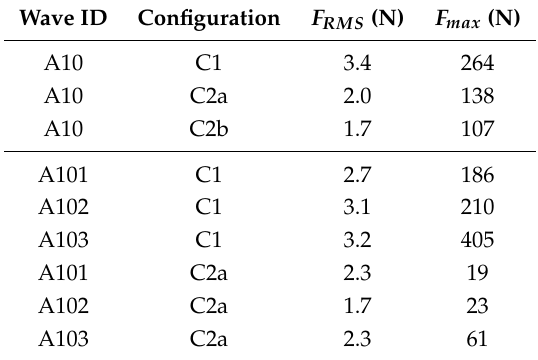
Figure 24. Time traces sample: 10-year wave, Configuration C2a. Table 14. Root mean square value and maxima peaks of mooring tension: 10- and 100-year